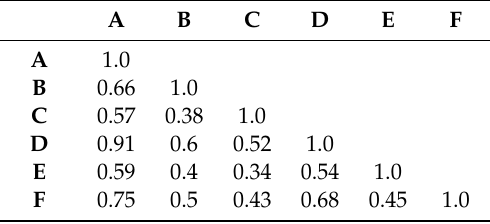
Table 4. The correlation coe ffi cients on spring among the seasonal Weibull distributions of the six farms.